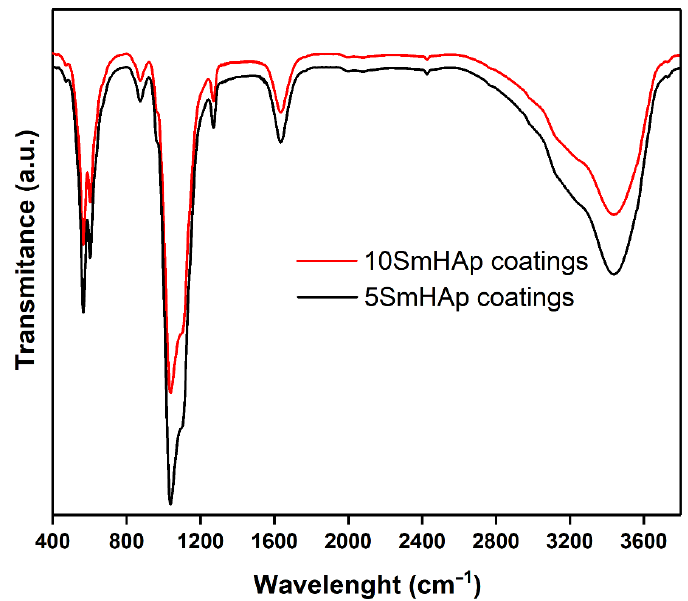
Figure 2. FTIR spectra of 5SmHAp and 10SmHAp coatings deposited on Si substrate.